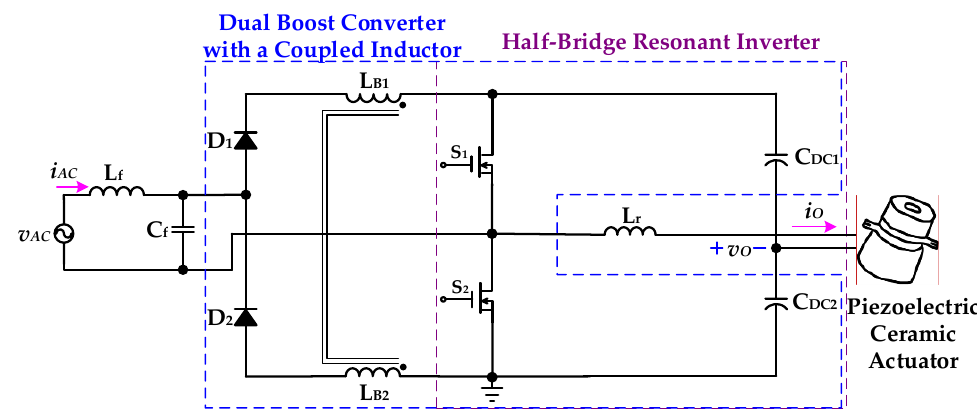
Figure 5. The proposed drive circuit for supplying a piezoelectric ceramic actuator with PFC. Table 1. Comparisons between the conventional drive circuits and the proposed version for a piezoelectric ceramic actu- ator.